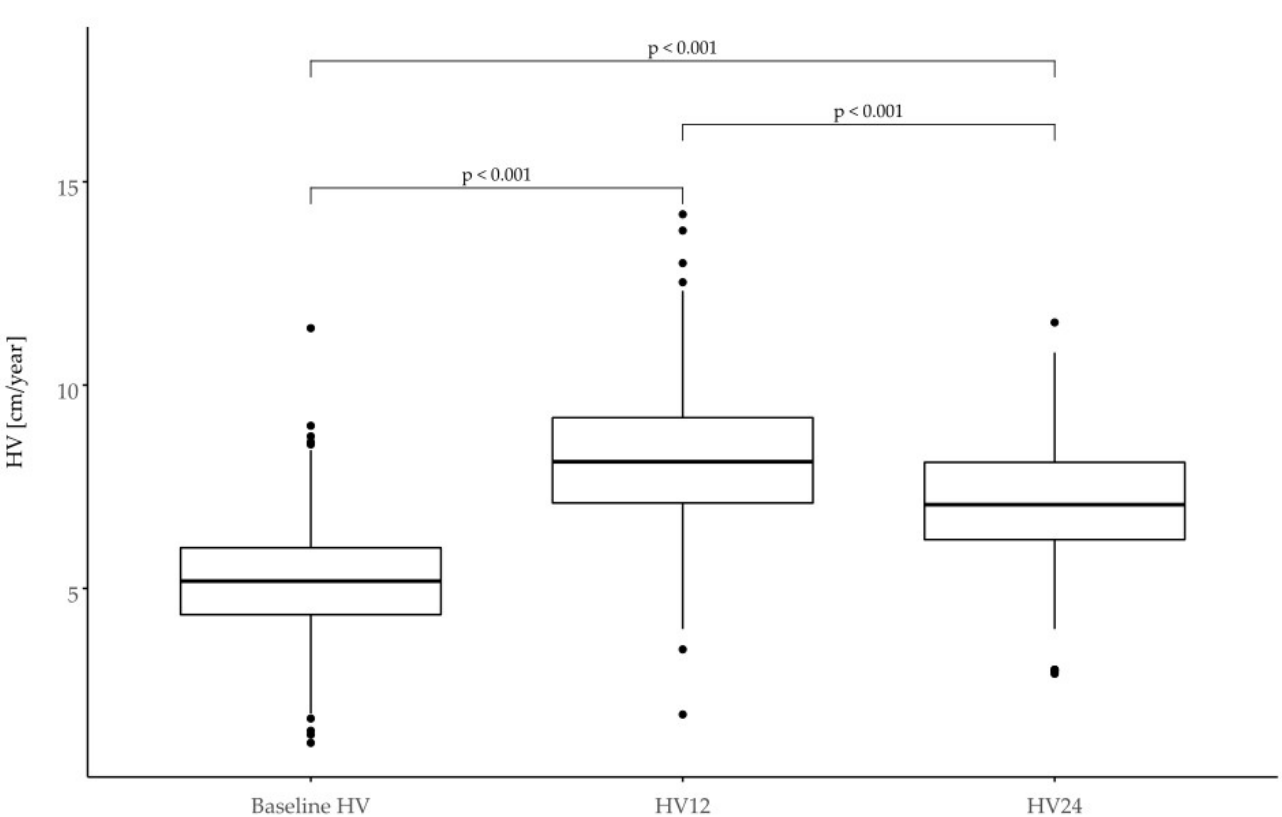
Figure 3. High velocity (HV) in SGA children expressed in cm/year at the baseline and after 12 and 24 months of treatment.